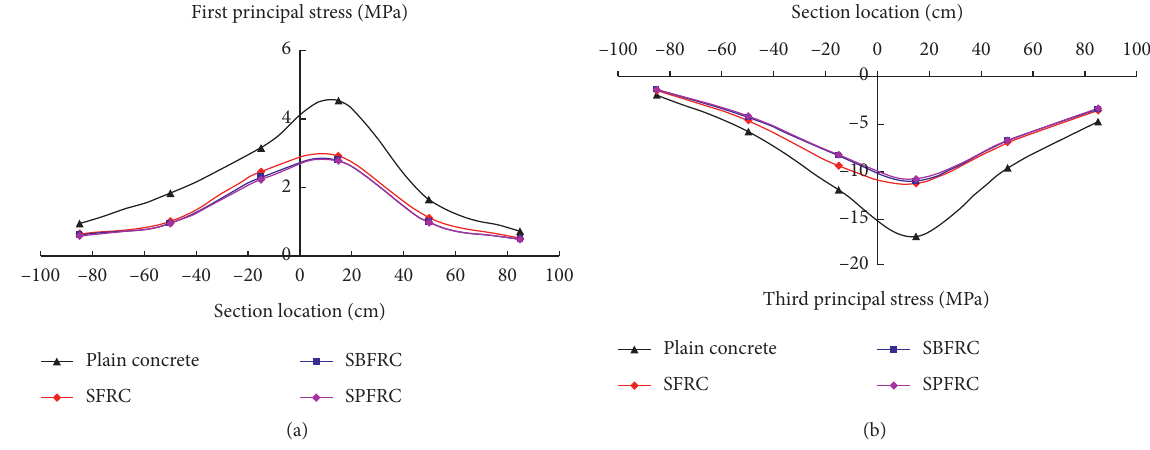
Figure 8: The principal stress. (a) The first principal stress. (b) The third principal